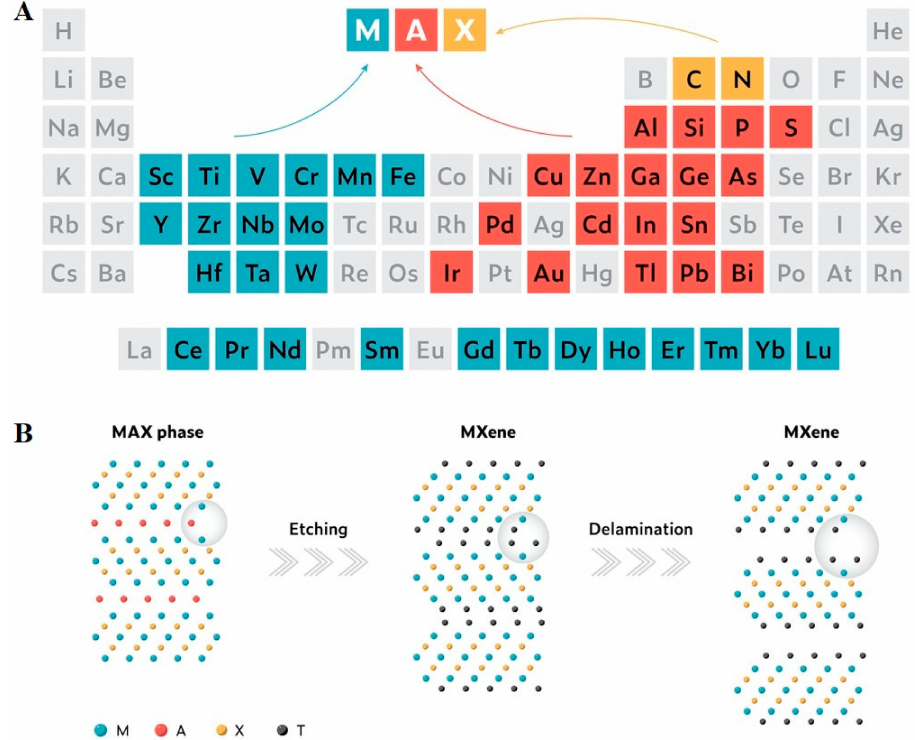
Figure 1. ( A ) The periodic table highlighting the ‘M’, ‘A’, and ‘X’ elements of known MAX phases. ( B ) Schematic illustration of the synthesis of MXenes from MAX phases. Reprinted with permission from Ref. [46]. Copyright © 2022